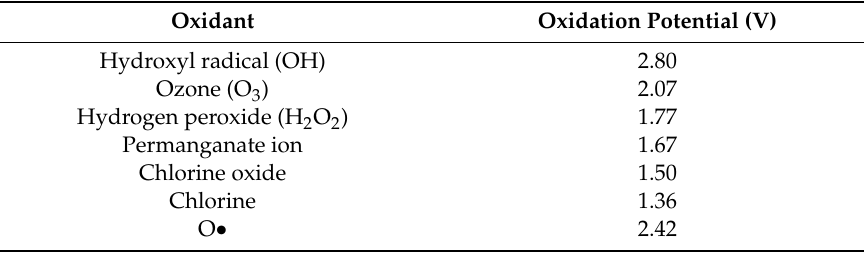
Figure 3. The expected radicals and species in argon–air mixture plasma jet. Table 2. Oxidation potential of di ff erent chemical